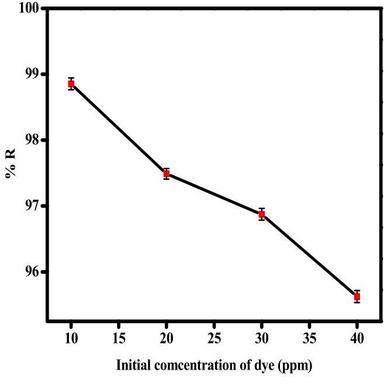
Effect of temperature.